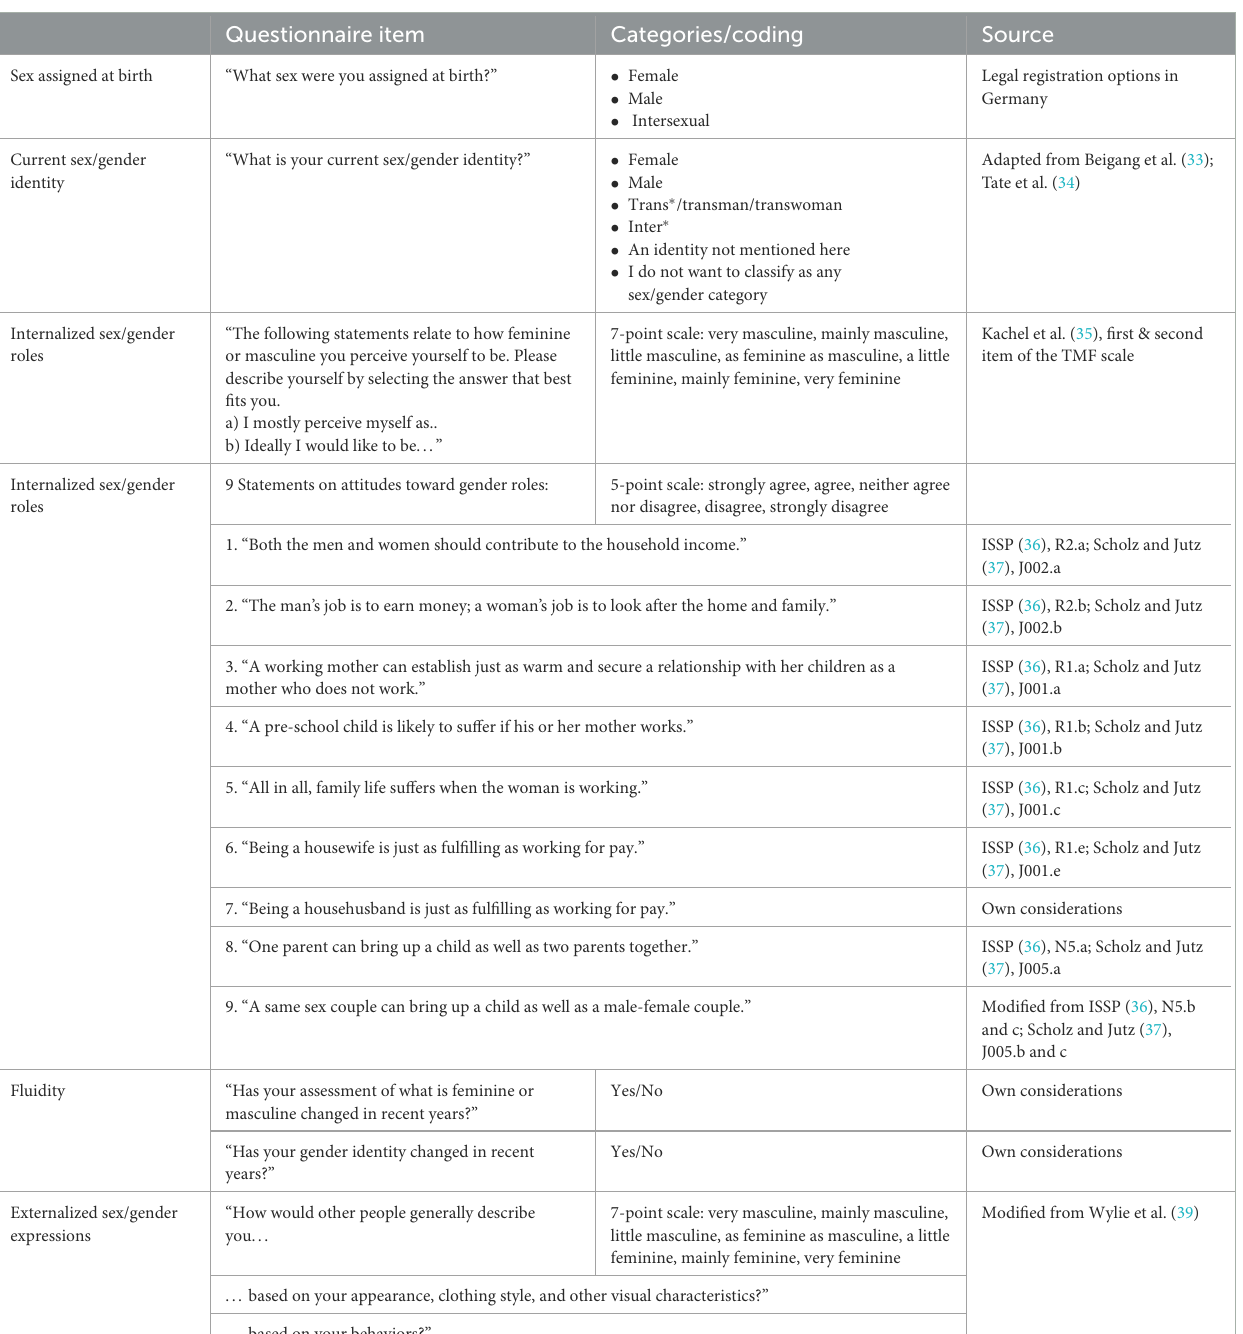
TABLE 1 Operationalization of the individual sex/gender